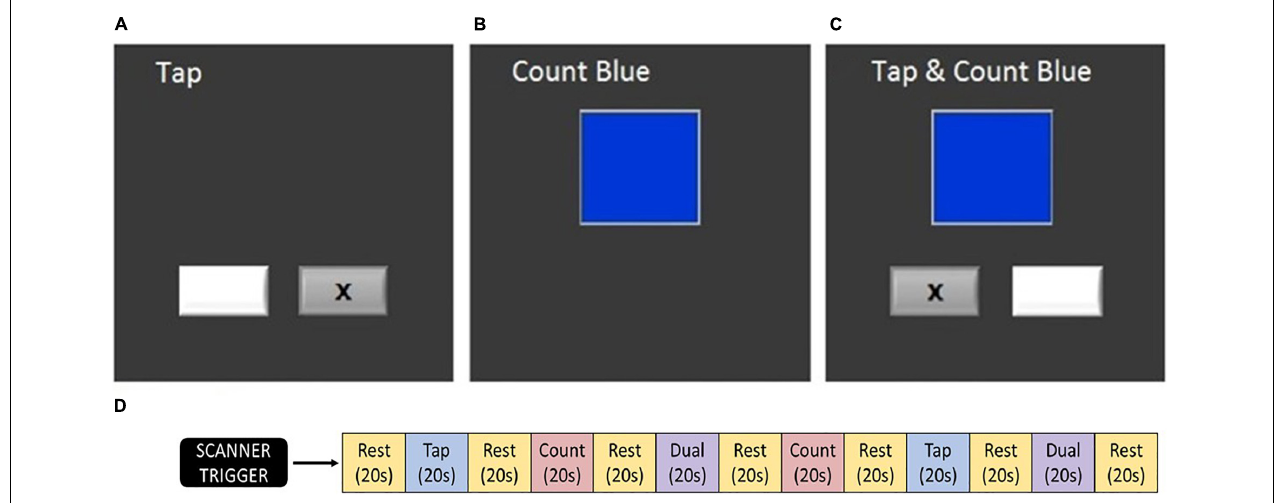
FIGURE 2 | Testing paradigm. (A) Tapping task, (B) counting task, (C) dual task, and (D) order of task blocks (Yuan et al., 2016). At each testing session, this sequence was conducted twice. Participants completed these tasks during fMRI